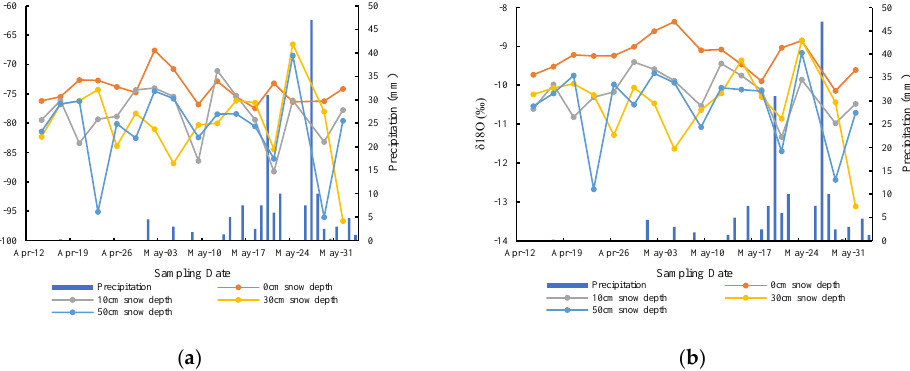
Figure 6. The change with time of δD and δ 18 O in soil water of different snow depth in 20 – 30 cm soil depth. ( a ) The change of δD ( b ) The change of δ 18 O Variance analysis was used to further analyze the differences in the isotope values of each soil layer, and the results are presented in Tables 4 and 5. Table 4 shows that for the different snow depth and the same soil layer, the soil water’s isotope values of the 50 cm snow depth plot and the other snow depth plots were significantly different ( p < 0.05), and there was no significant difference between the other three snow depth plots (0, 10, and 30 cm). For the different snow depths, the soil water’s isotope values in the 0– 10 cm soil layer were greatly affected by precipitation. As the snowmelt completion time increased, the difference between the soil water’s isotopes and the atmospheric precipitation’s iso- topes gradually decreased. However, as the soil depth increased, the influence of the at- mospheric precipitation on the soil water’s isotopes was weakened or delayed. The distri- butions and trends of the deuterium and oxygen isotopes were highly consistent. Table 5 shows that there was a significant difference between the 20 – 30 cm layer and the other two layers ( p < 0 .05); while there was no difference in the soil water’s isotope values be- tween the 0 – 10 cm and 10 – 20 cm layers.